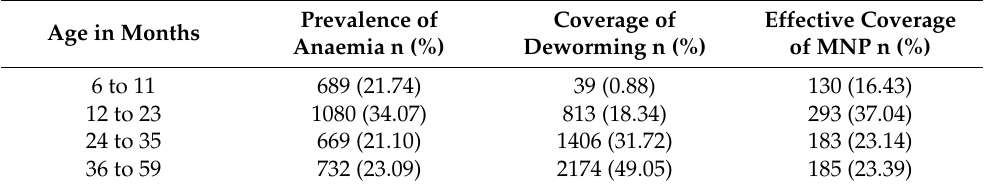
Table 2. Percentage of children who were anaemic, received deworming medication, and MNP effective coverage by age